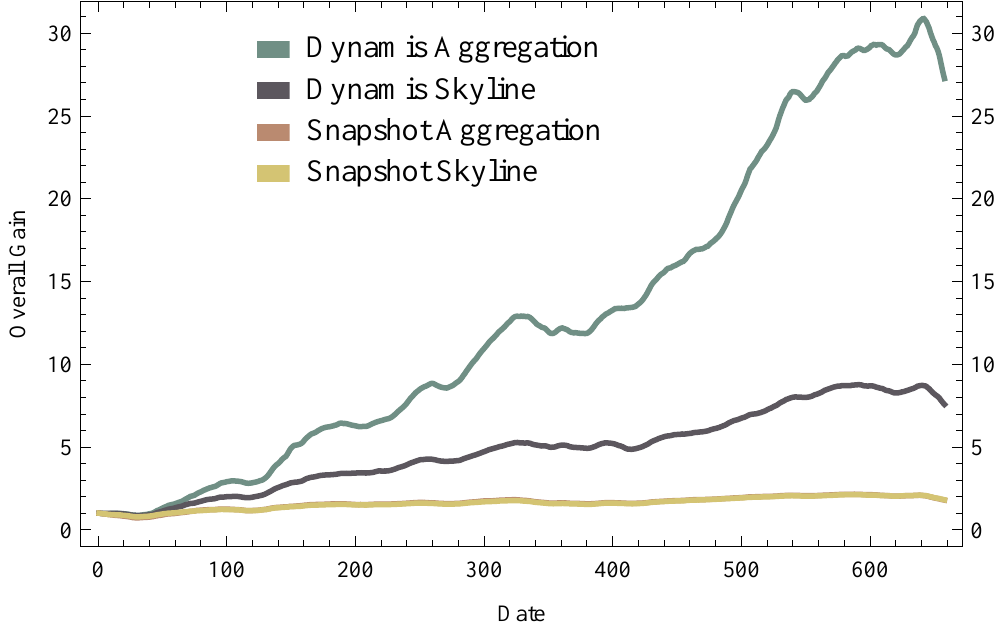
Figure 16. Overall gain ( OG ) with k = 10 and w =